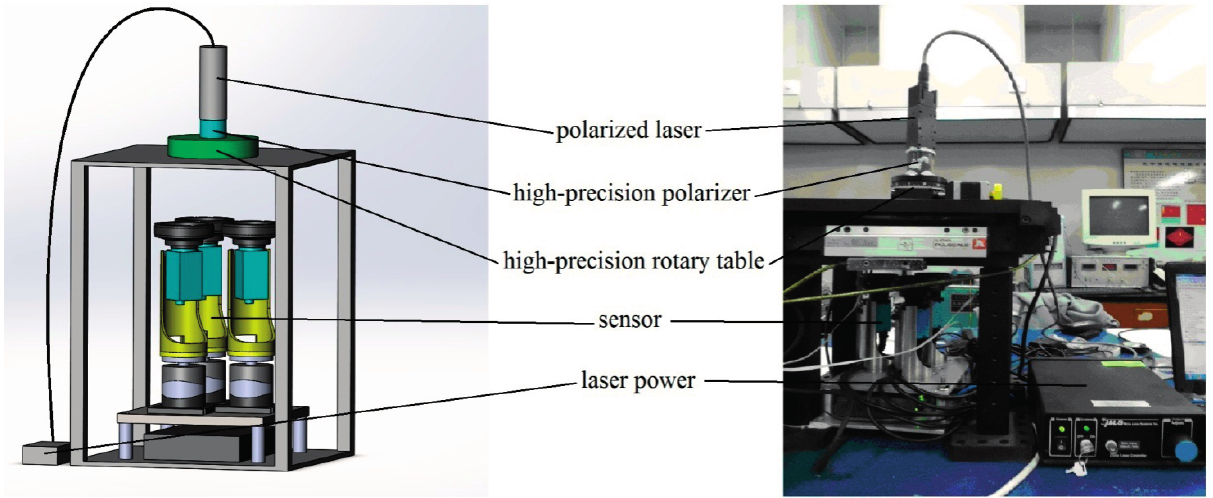
Figure 5. Left: diagrammatic sketch of the polarized light. Right: The polarized